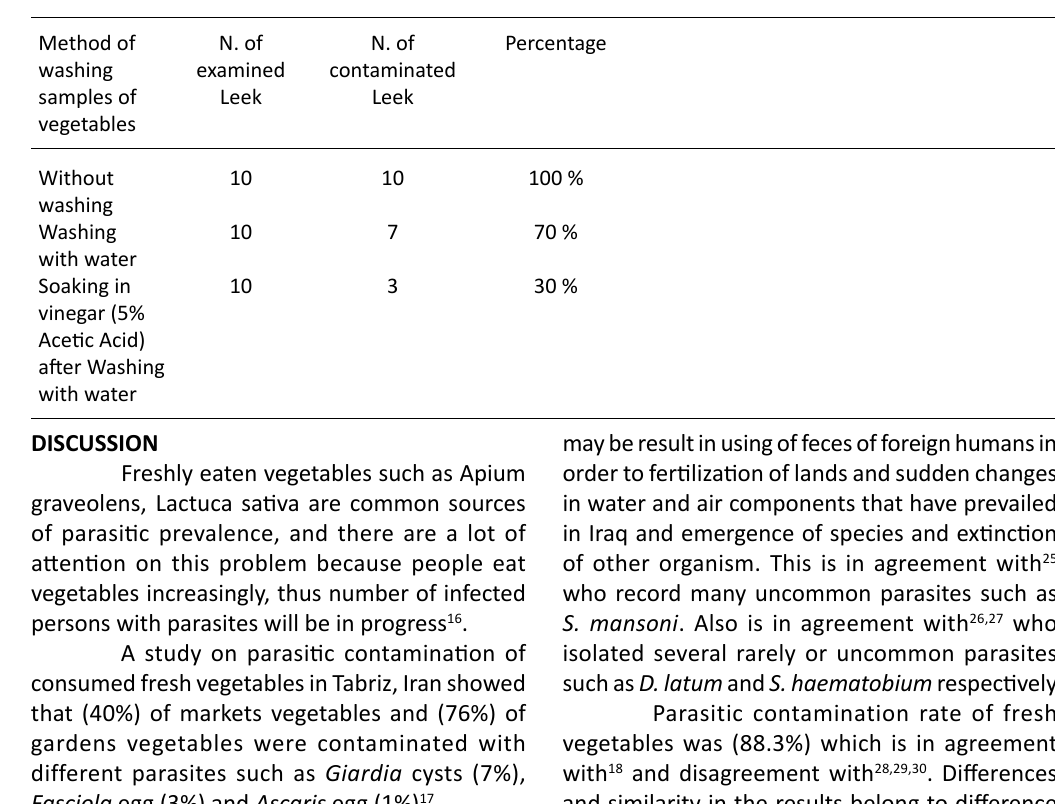
Table 5. Effect of vinegar (5% Acetic Acid ) on percentage of contamination with intestinal parasites that diagnosed on vegetables ( Allium porrum (Leek) as example). N. of